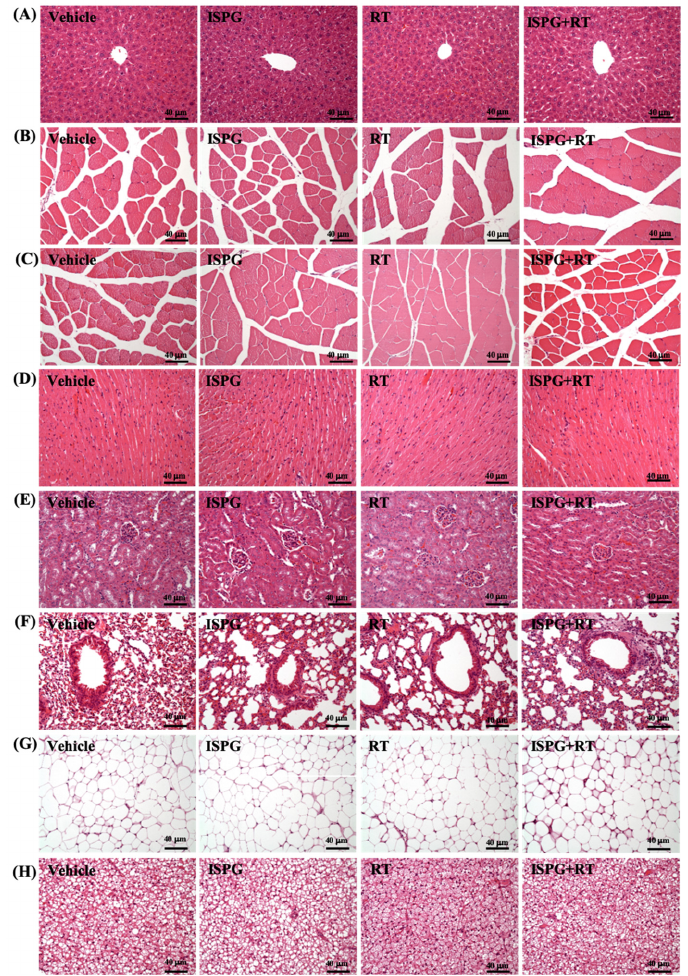
Figure 8. Effect of ISPG and RT on histomorphologic features of the ( A ) liver, ( B ) gastrocnemius muscle, ( C ) quadriceps, ( D ) heart, € kidney, ( F ) lung, ( G ) epididymal fay pads, and ( H ) brown adipose tissue. Specimens were photographed under a light microscope (HE stain, magnification: 200×; bar, 40 µm).